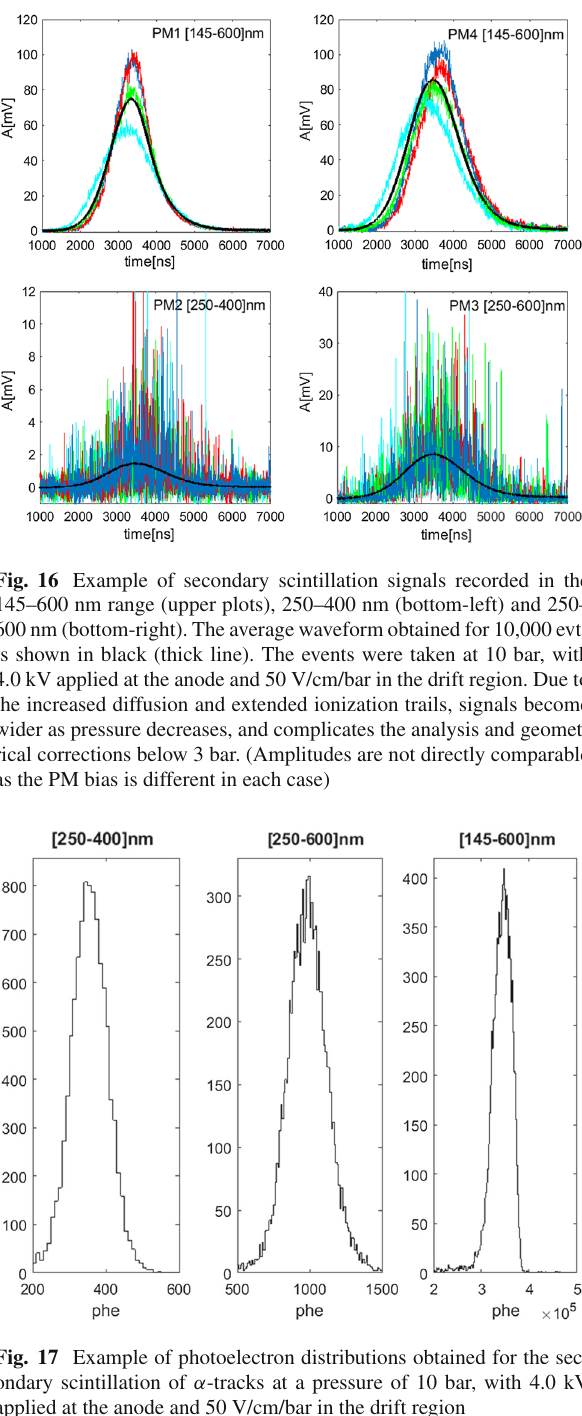
calibrations and histogrammed. Soft cuts in low energy events were applied to avoid outliers, and the average value of the histograms was used as an estimate of the yields (Fig. 17). By applying the Geant4 corrections with the same param- eters as for the primary scintillation signals, and given the good agreement obtained with earlier measurements in